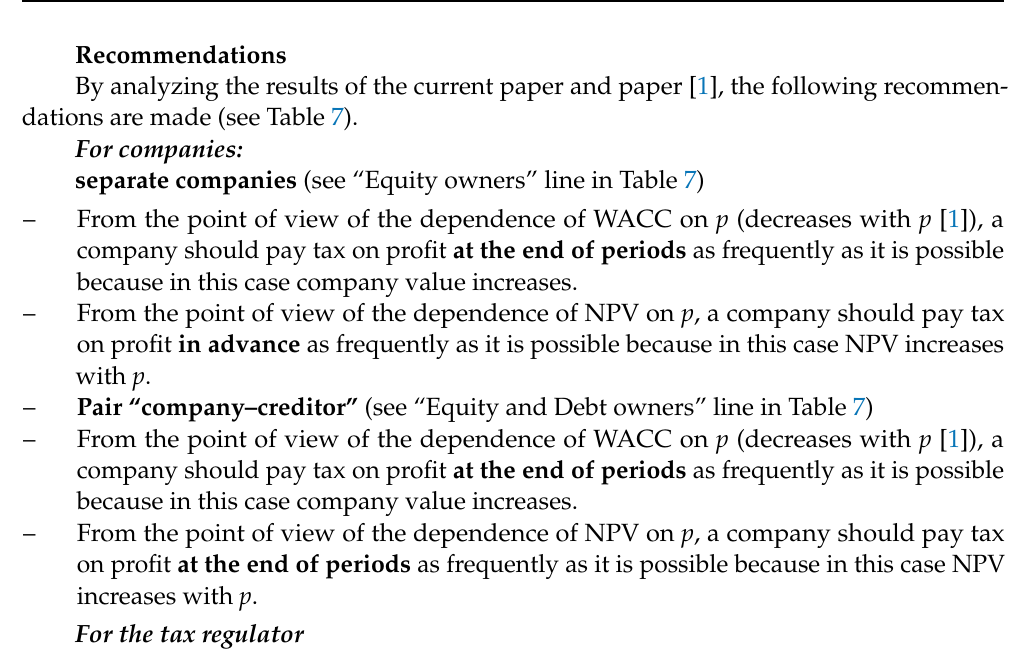
Table 7. General conclusions: comparing the results of the current paper and paper [1]. Payments of Tax on Profit at Payments of Tax on the Ends of Periods Profit in Advance WACC Decreases with p Increases with p Equity owners Decreases with p Increases with p NPV Equity and debt owners Increases with p Decreases with p